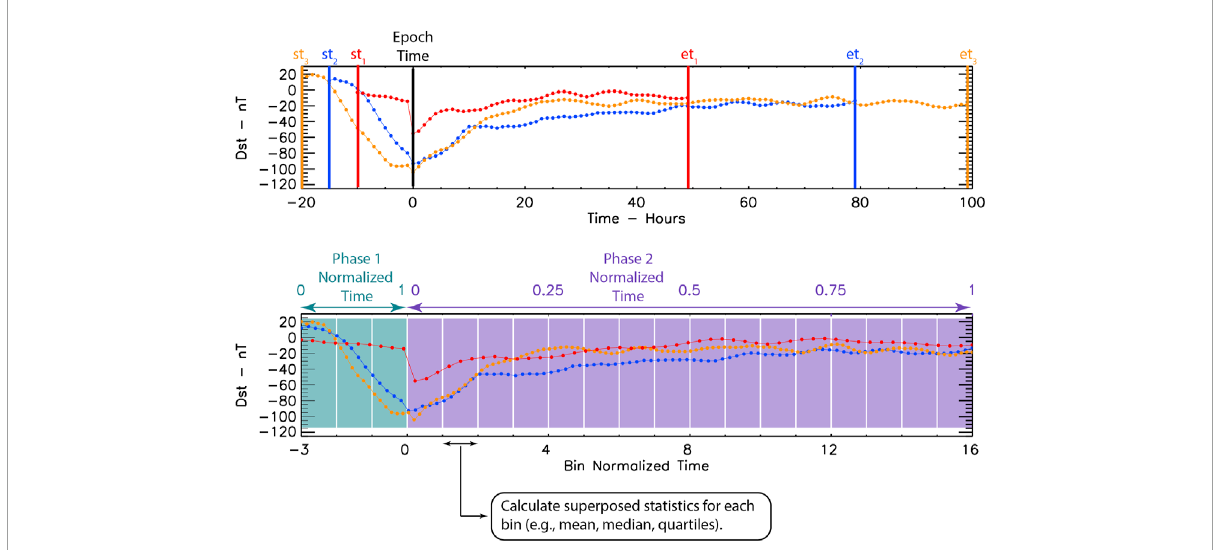
FIGURE 1 Illustration of how the time-normalized superposed epoch analysis is performed on the Dst index. The top panel shows the conventional SEA alignment, where st 1,2,3 and et 1,2,3 represent the start times and end times, respectively, of three different geomagnetic storms, aligned at their epoch times. The bottom panel shows the time-normalized SEA for the same storms. Phase 1 and phase 2 are highlighted as labeled, where each colored block represents a single normalized time